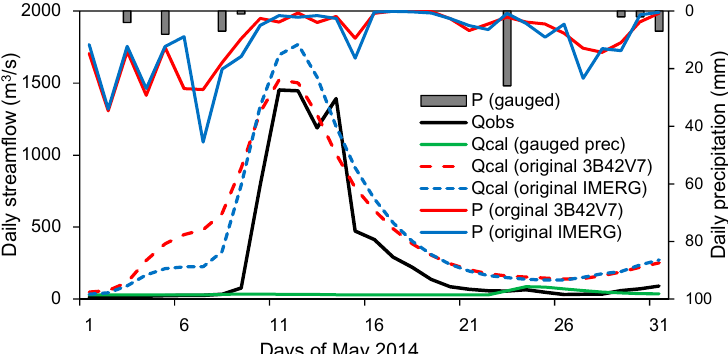
Figure 11. Simulated daily hydrographs in May 2014 using the gauge-based precipitation data, the original 3B42V7 product, and the original IMERG precipitation estimates at Hkamti station. P (gauged) represents the gauge-based, basin-averaged daily precipitation; P (original 3B42V7) and P (original IMERG) represent the original basin-averaged 3B42V7 and IMERG daily precipitation. The other terms in the figure are the same as in Figure 8.